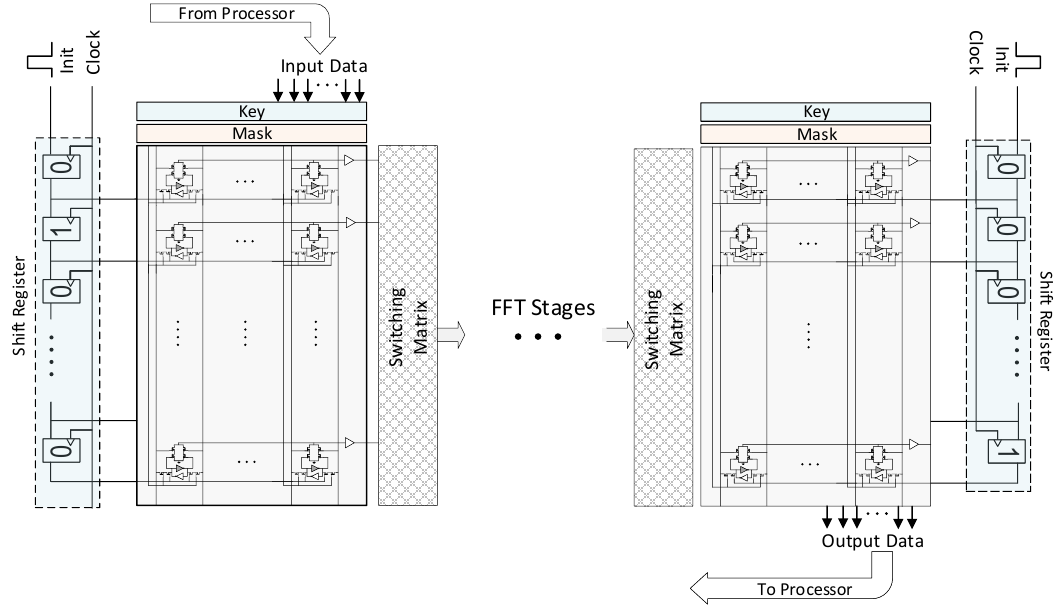
Figure 4. Pipelined in-memory FFT processor